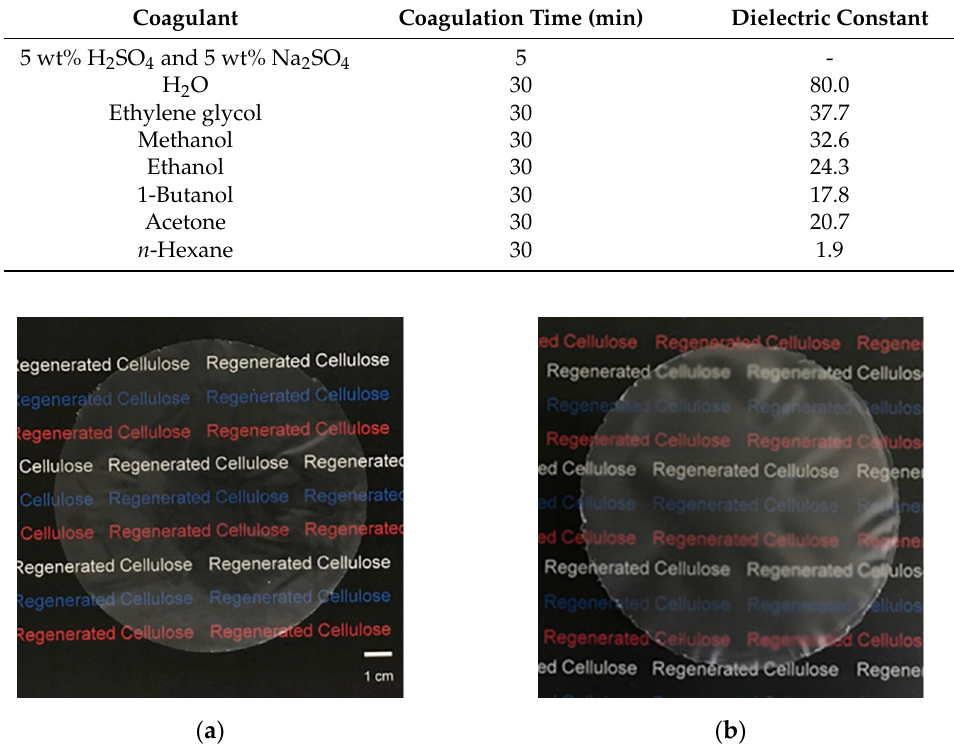
Figure 2. Images of regenerated cellulose film prepared from ( a ) 3 wt% CNF and ( b ) 9 wt% MCC solution in LiOH–urea–H 2 O and coagulated with methanol. Table 1. Preparation conditions of regenerated cellulose film and polarity of coagulants.